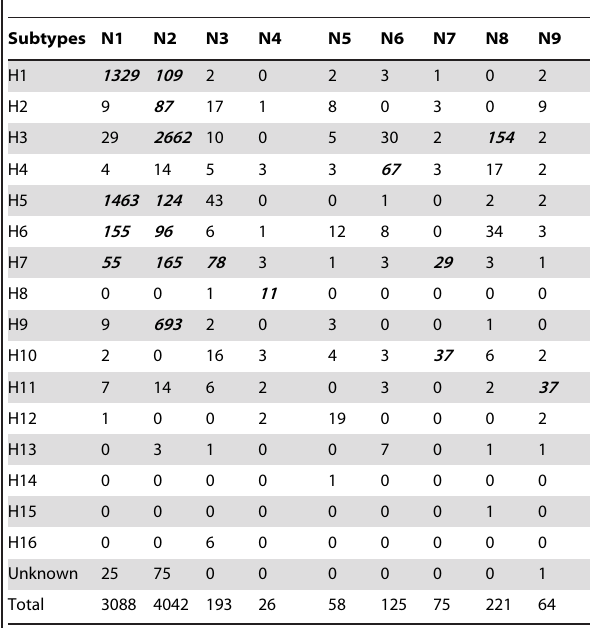
Table 2. HA-subtype distribution of 7892 influenza A viruses with NA sequences in